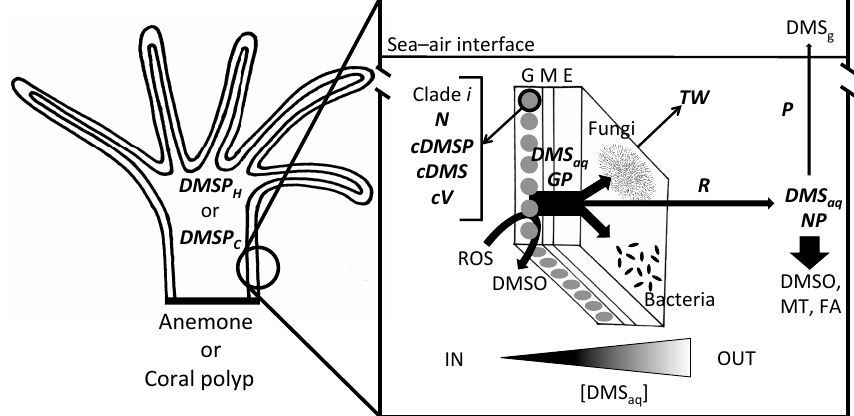
Figure 1. Magnification of a coral polyp and its cell layers with particular emphasis on the pathway of DMS from its production by en- dosymbionts (grey circles) to its release to the atmosphere. Note that symbols in bold italics describe the parameters fed into the simulation framework. The host with a particular tissue weight (TW) accommodates a number N of cells for Symbiodinium clade i containing DMSP (cDMSP, cellular DMSP), producing and releasing DMS (cDMS, cellular DMS production rate), and having a particular volume (cV, cellular volume). All cells of all clades i form the total DMSP concentration within the anemone holobiont or corals (DMSP H and DMSP C , respec-